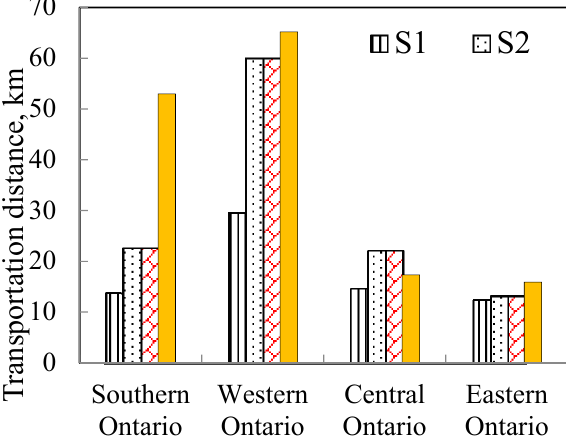
Figure 2. Feedstock transportation distance at different locations in